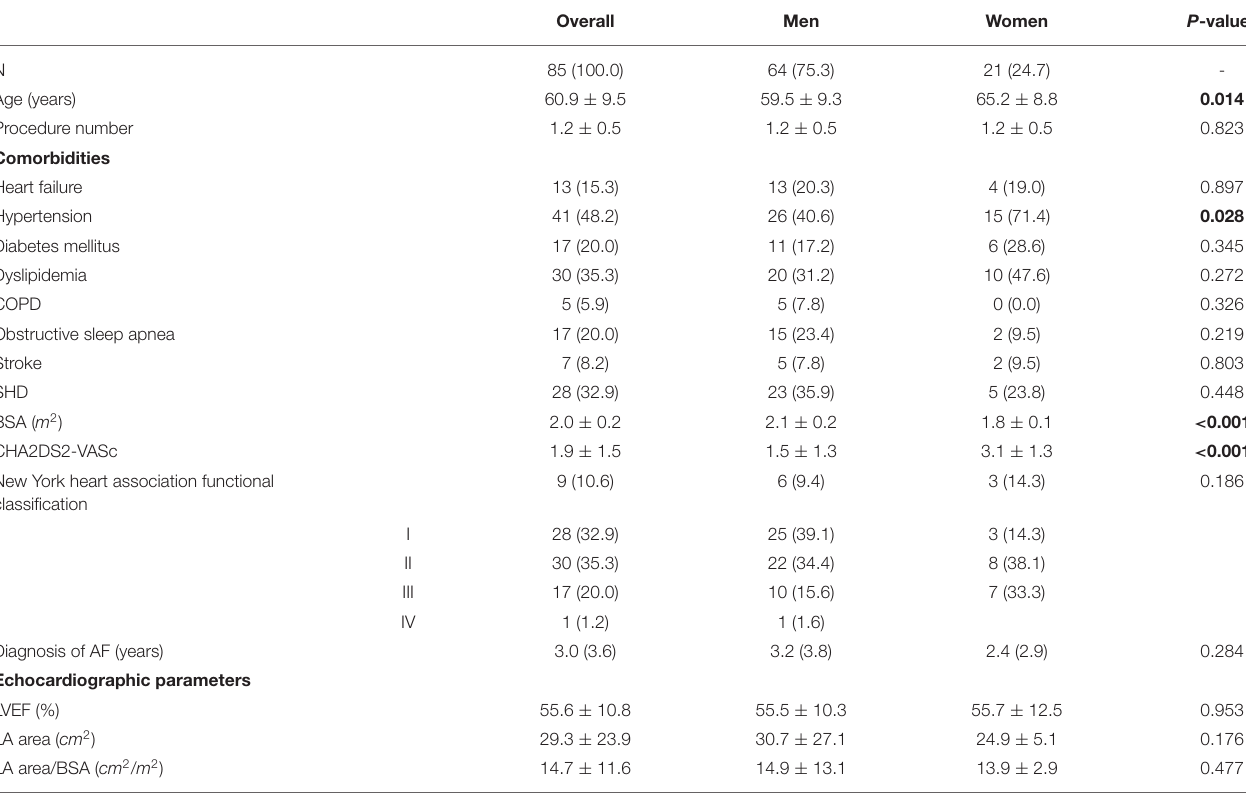
Values in the table are n (%) or mean ± SD. COPD, chronic obstructive pulmonary disease; SHD, structural heart disease; BSA, body surface area; NYHA, New York Heart Association; LVEF, left ventricular ejection fraction; and LA, left atrium. * Categorical data with the chi-square test for categorical data, continuous variables using Welch’s two-sample t-test, and proportions based on normal z-test. Bold values indicates statistical